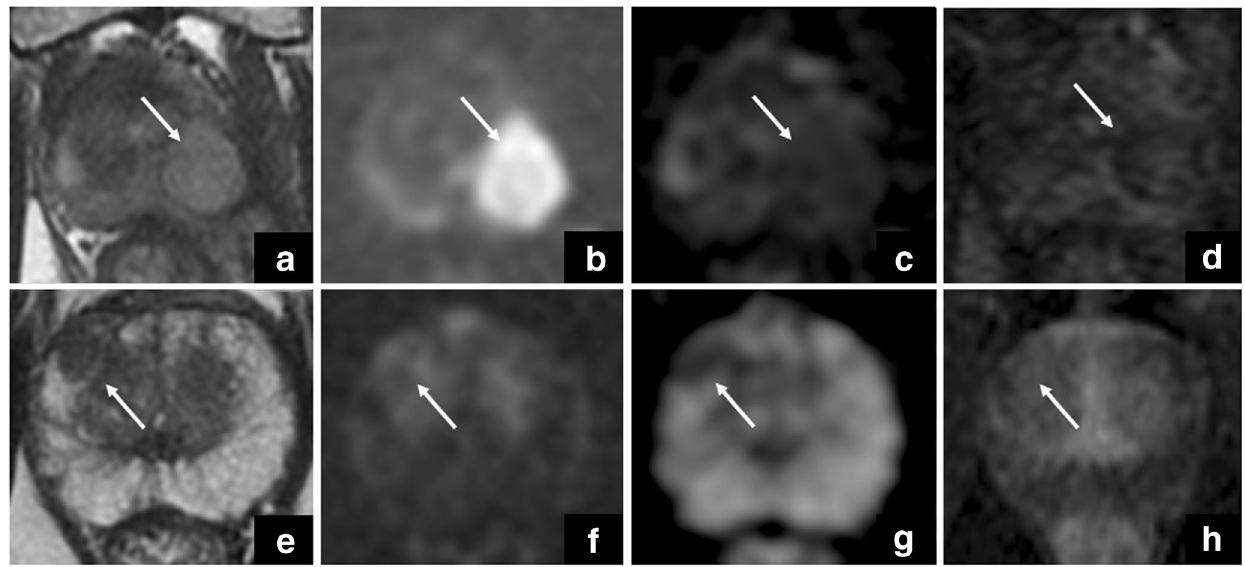
Fig. 13 The first four images show a round-shaped area characterised by intermediate signal intensity on T2-weighted imaging ( a ), restricted diffusion on DWI ( b ) and in the ADC map ( c ), and ring enhancement ( d ). These findings, together with clinical history, orient towards the diagnosis of abscess. The other four images show a focal nodule in the